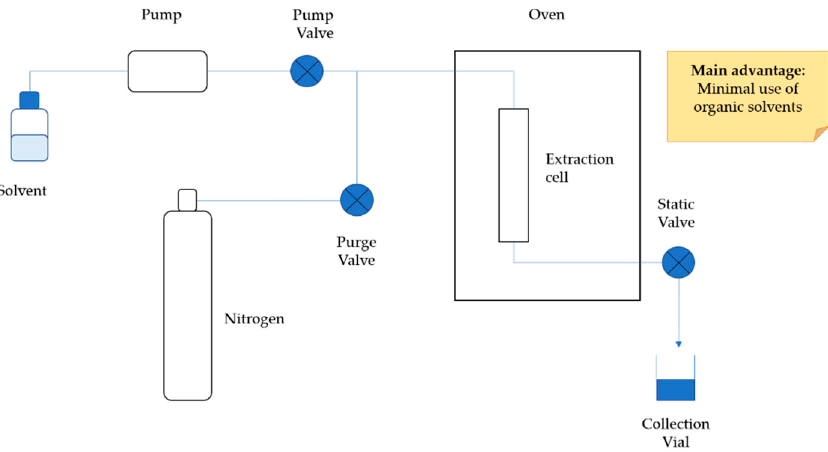
Figure 6. Schematic representation of typical PLE equipment.